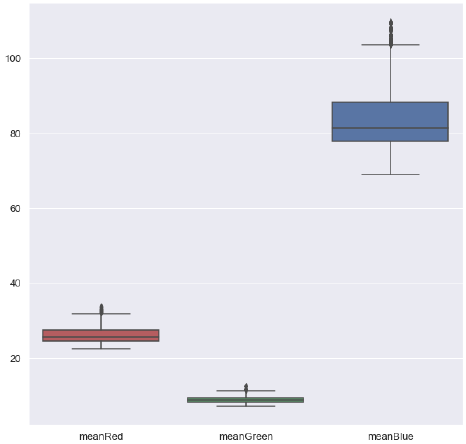
Figure 17. Range of means of the blue, green, and red